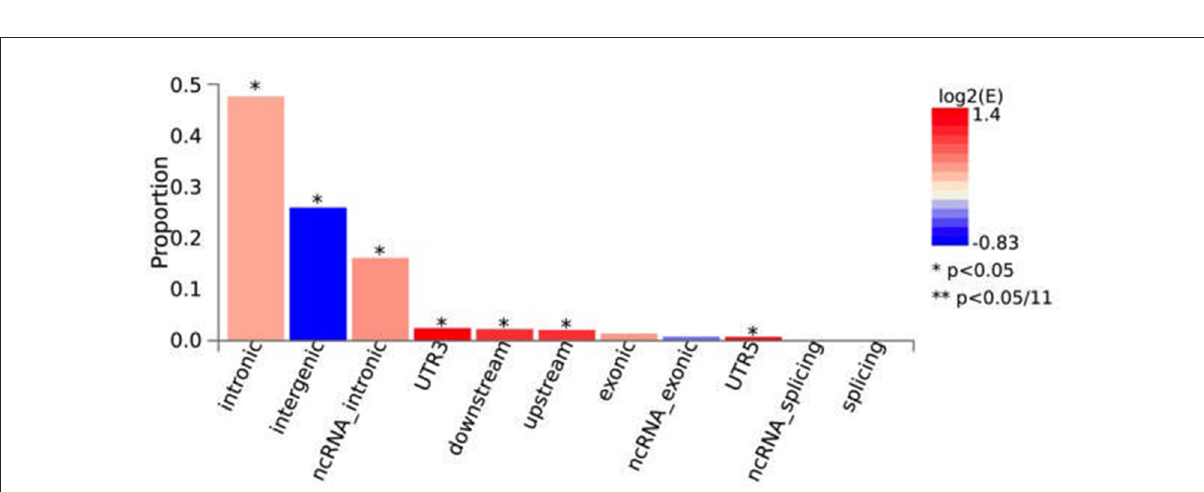
FIGURE2 Functional consequences of ASSET candidate SNPs on genes. The histograms display the proportion of SNPs (all SNPs in LD with independent significant SNPs) which have corresponding functional annotation assigned by ANNOVAR. Bars are colored by log2 (enrichment) relative to all SNPs in the selected reference panel. Enrichment is computed as (proportion of SNPs with an annotation)/(proportion of SNPs with an annotation relative to all available SNPs in the reference panel). Proportion is the fraction of candidate SNPs with the corresponding annotation. Fisher’s exact test (two side) is performed for each annotation. * p < 0.05; ** p <